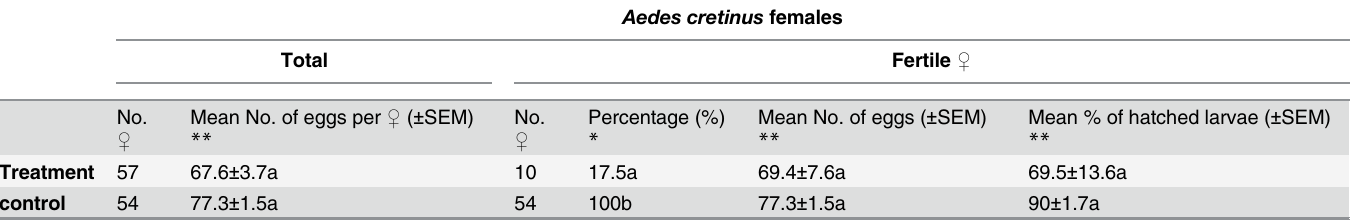
Table 2. Oviposition and fertility of Ae . cretinus females previously crossed with Ae . albopictus (treatment) or Ae . cretinus (control) males in groups of 20 and then paired with Ae . cretinus males individually. Aedes cretinus